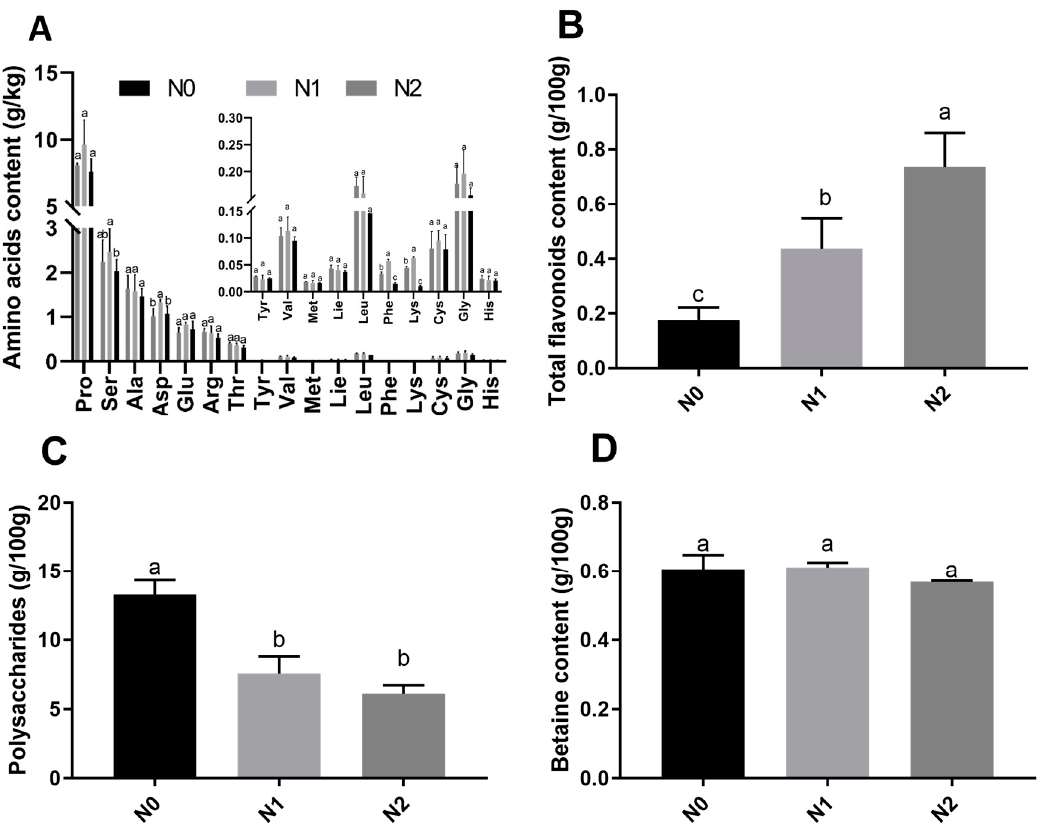
Figure 2. Nutrient contents of goji fruits. The small letter indicates a significant difference ( p < 0.05) as analyzed by Duncan’s multiple tests. ( A ) Amino acid contents of goji fruits; ( B ) total flavonoid contents of goji fruits; ( C ) polysaccharide contents of goji fruits; and ( D ) betaine contents of goji fruits.